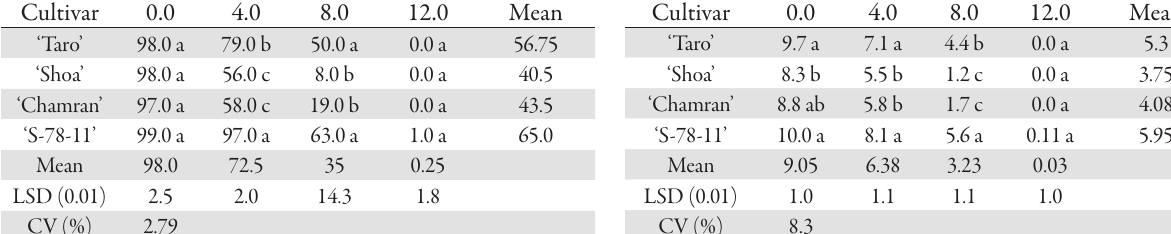
Tab. 1. Effect of salinity (ds m -2 ) on germination percentage of different wheat cultivars Cultivar